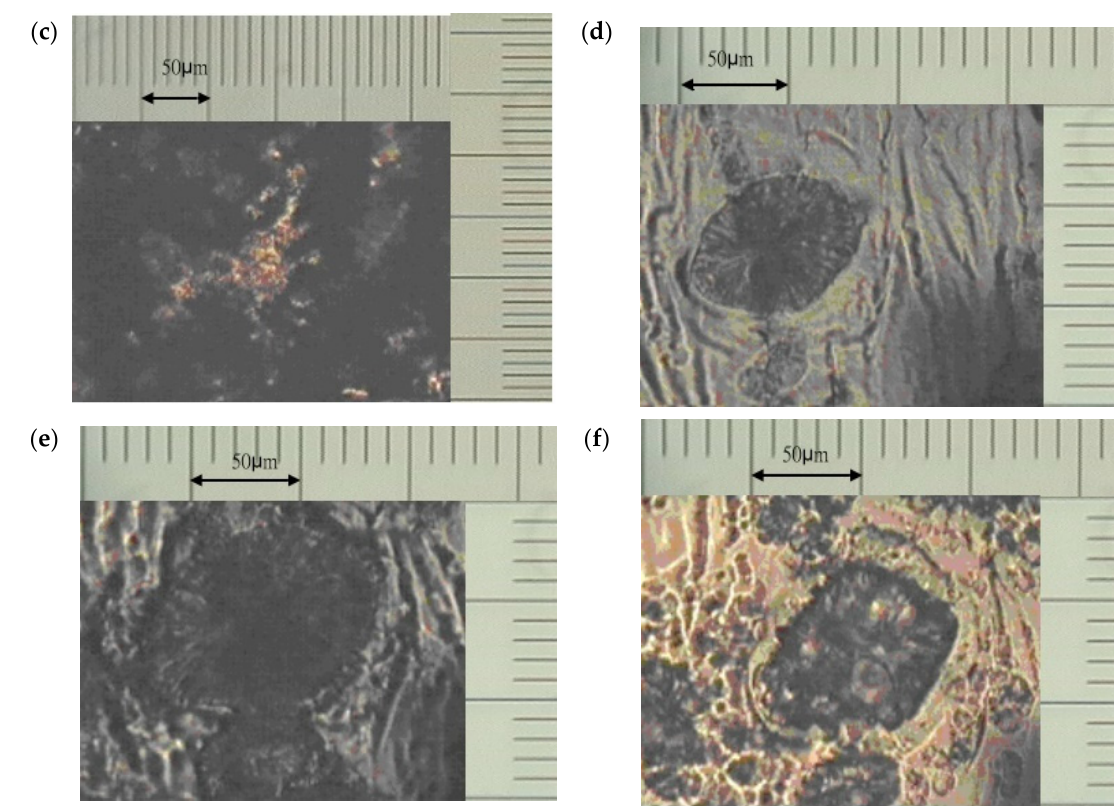
Figure 2. Polarized optical microscope (POM) image of ( a ) BP/B10 (2:1) 150 °C/1 h, 200×. ( b ) BP/B10 (2:1) 150 °C/5 h, 200×. ( c ) BP/B10 (2:1) 150 °C/5 h, ramp 10 °C/min to 210 °C, 200×. ( d ) BP/B10 (2:1) 160 °C/1 h, 500×. ( e ) BP/B10 (2:1) 160 °C/5 h, 500×. ( f ) BP/B10 (2:1) 160 °C/5 h, ramp 10 °C/min to 210 °C, 500×.